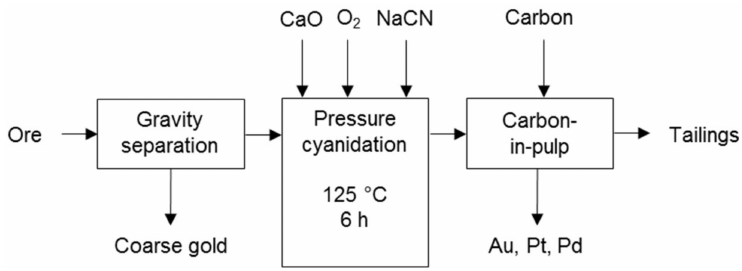
Figure 10. Cyanidation process diagram for Coronation Hill ore (adapted from Cole & Ferron [7]).